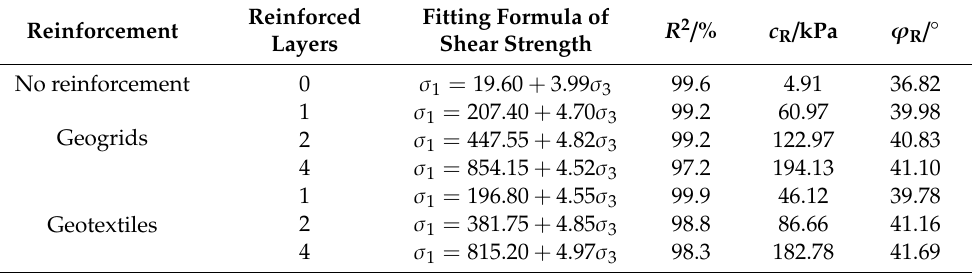
Figure 7. Shear strength curves of different reinforced layers: ( a ) geogrids, ( b ) geotextiles. Table 4. Shear strength index of reinforced tailings under different reinforced layers.